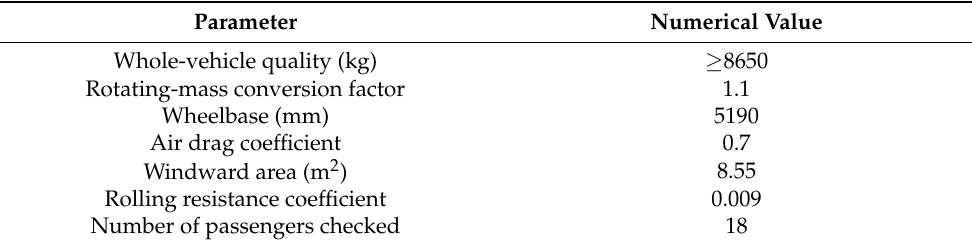
Table 1. Vehicle parameters of pure electric